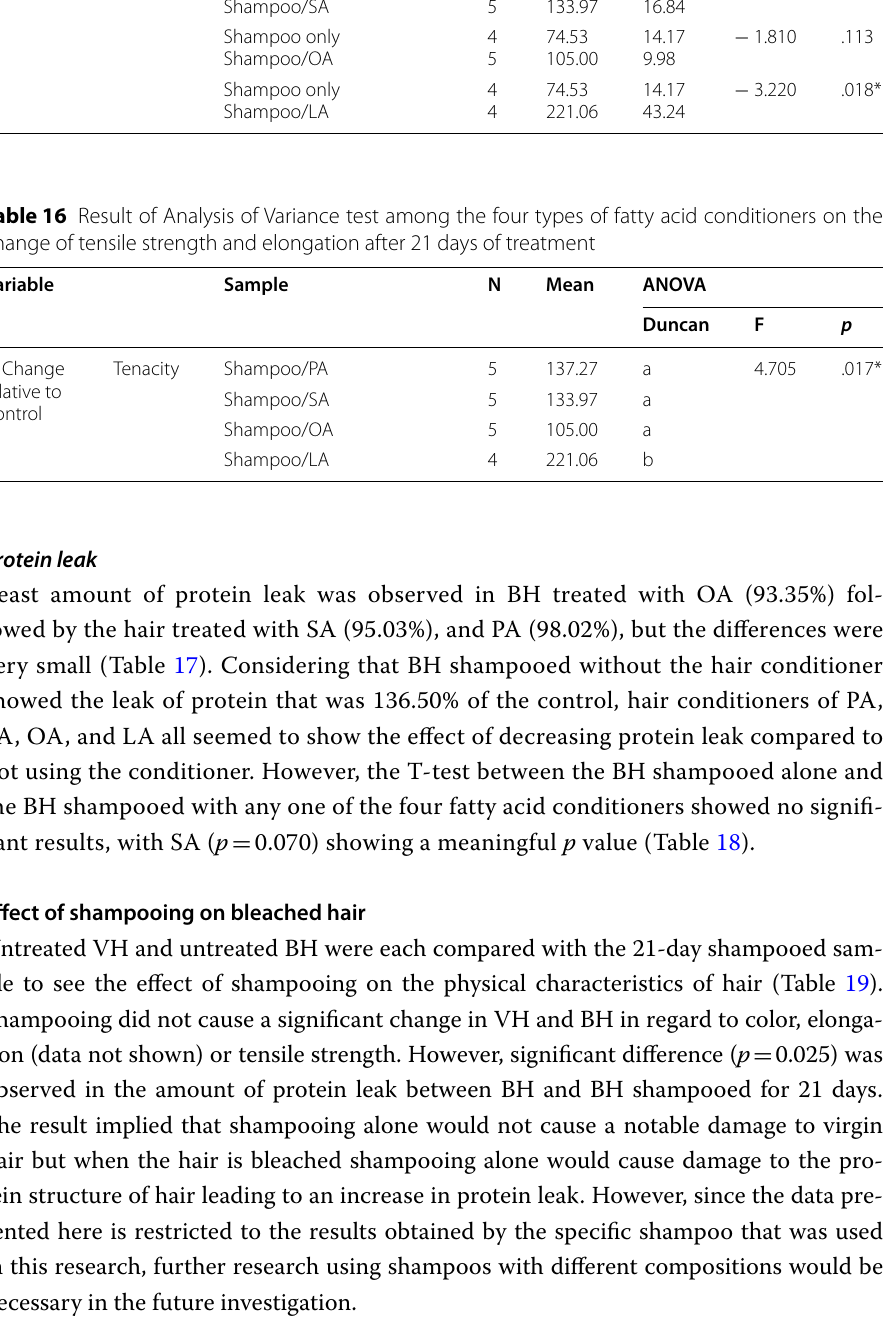
% Change relative to Control